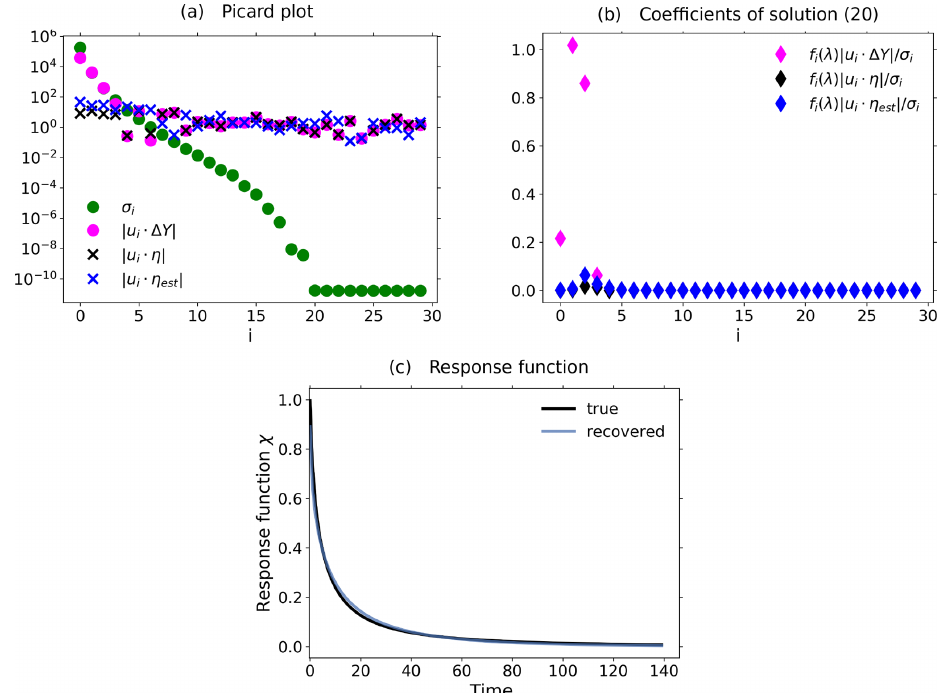
Figure 5. Demonstration of the operation of the RFI algorithm in the presence of noise using toy model data from a 1% and control experiment. To demonstrate the relevance of the noise-level adjustment (step 3 from Fig. 1), the standard deviation of the noise in the control experiment was taken to be 10 times smaller than that for the noise in the perturbed experiment. (a) Picard plot showing the singular values σ i and the projection coefficients of the data | u i • (cid:49)Y | , the “true” noise | u i • η | , and the final noise estimate | u i • η est | ; (b) coefficients of the regularized solution (Eq. 20); (c) “true” and recovered linear response functions. Since the RFI algorithm correctly adjusted the noise level to the “true” noise in the data, the resulting regularized solution has contributions only from the first few projection coefficients which are not completely obscured by noise. Overall, the recovery is almost perfect, because the SNR (chosen as about 520) is still sufficiently good and because the noise was chosen to conform with the spectral similarity assumption. The regularization parameter determined by the algorithm is λ ≈ 30364. Because the noise-level adjustment (step 3 from Fig. 1) already gave a good estimate of the “true” noise in the data, no monotonicity check was needed (step 6 from Fig.